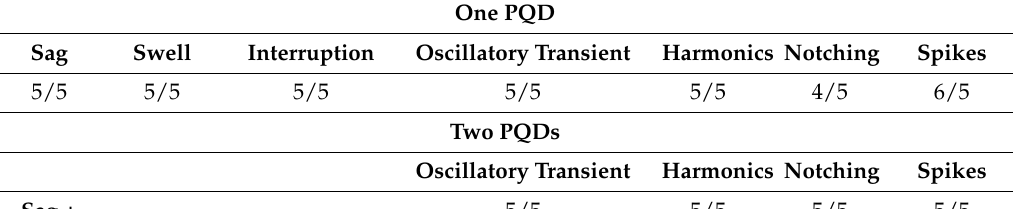
Figure 6. ( a ) Experimental setup and ( b ) electric circuit.